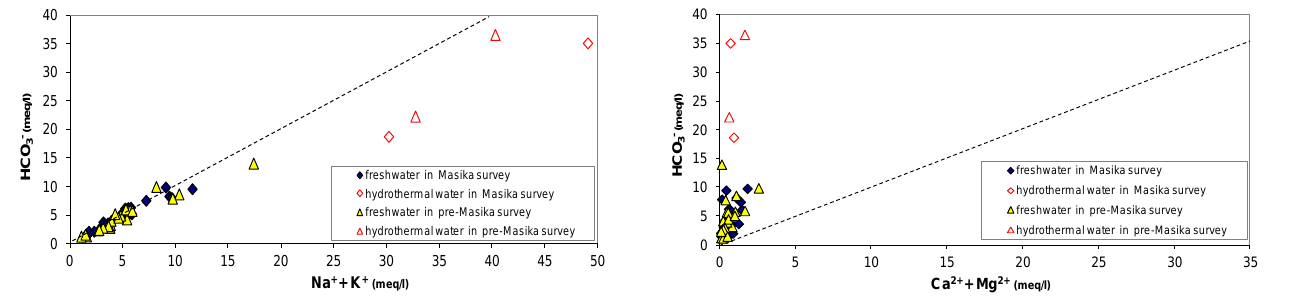
Fig. 11. Plot of Na + +K + vs. alkalinity. Fig. 12. Plot of Ca 2 + +Mg 2 + vs.